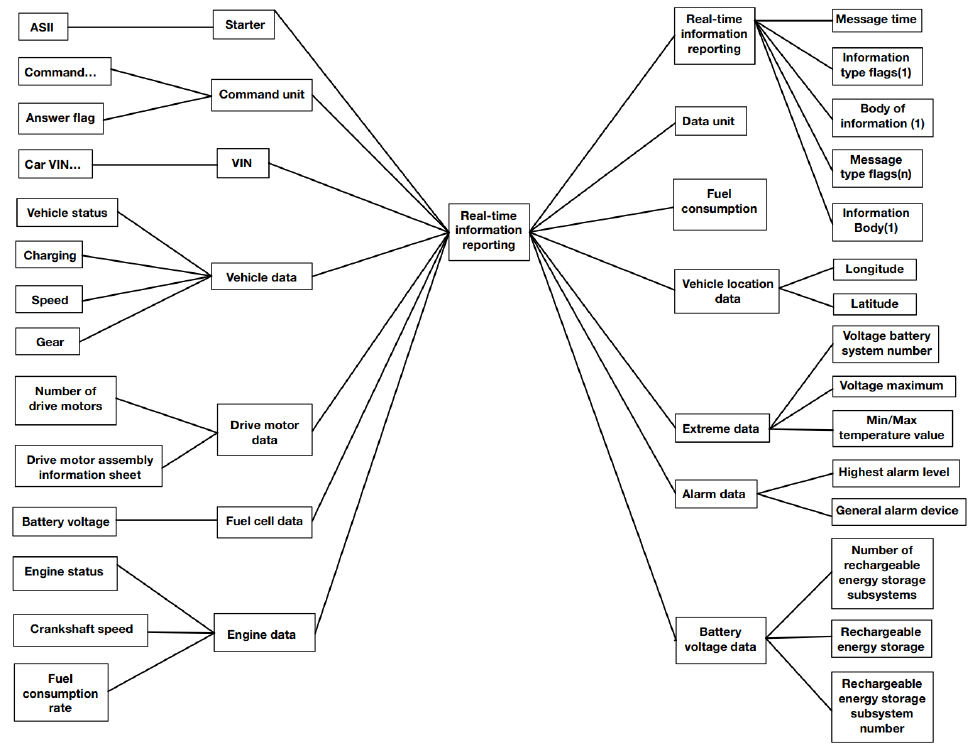
Figure 5. Analysis of real-time information-reporting type message.